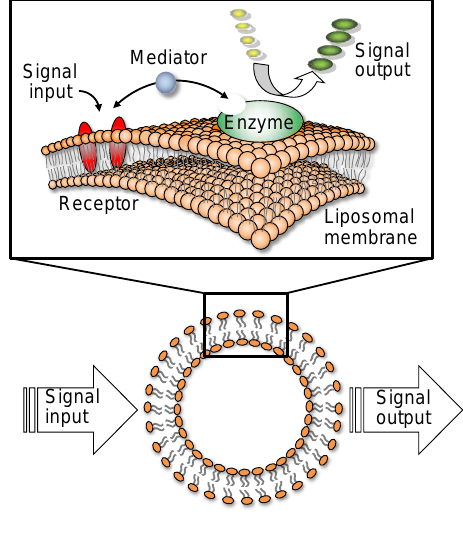
Figure 1. Schematic illustration of a liposomal molecular device inspired by biological signal transduction